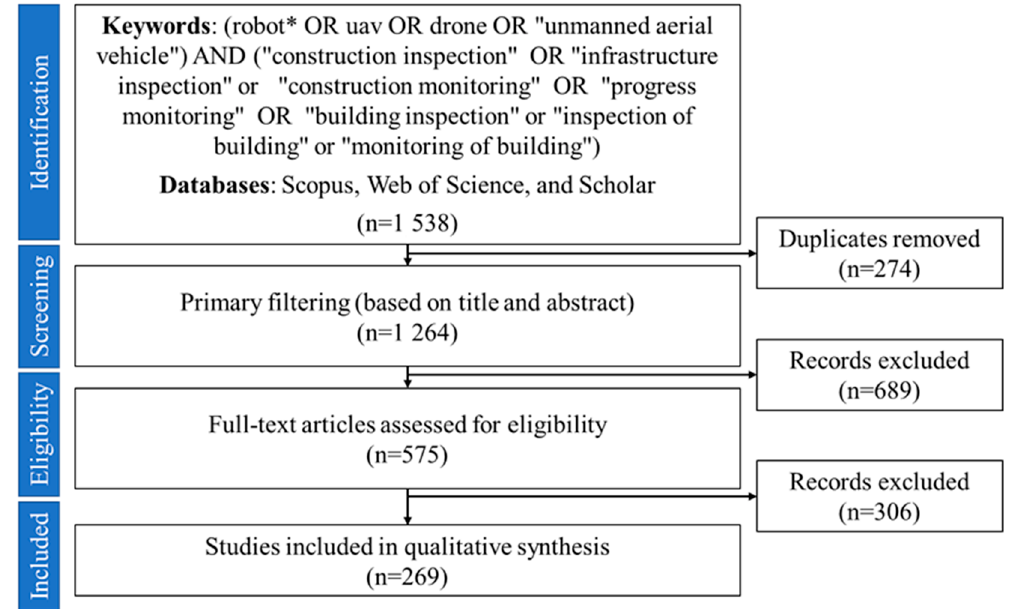
Figure 1. Methodology used for the selection of sources.